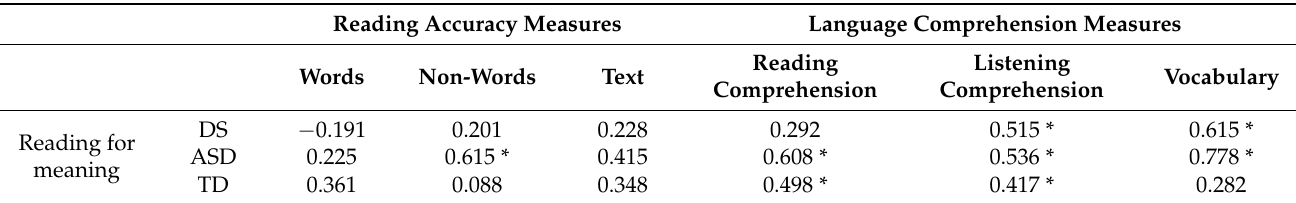
Table 4. Correlations between homograph reading accuracy, reading accuracy, and language comprehension. Reading Accuracy Measures Language Comprehension